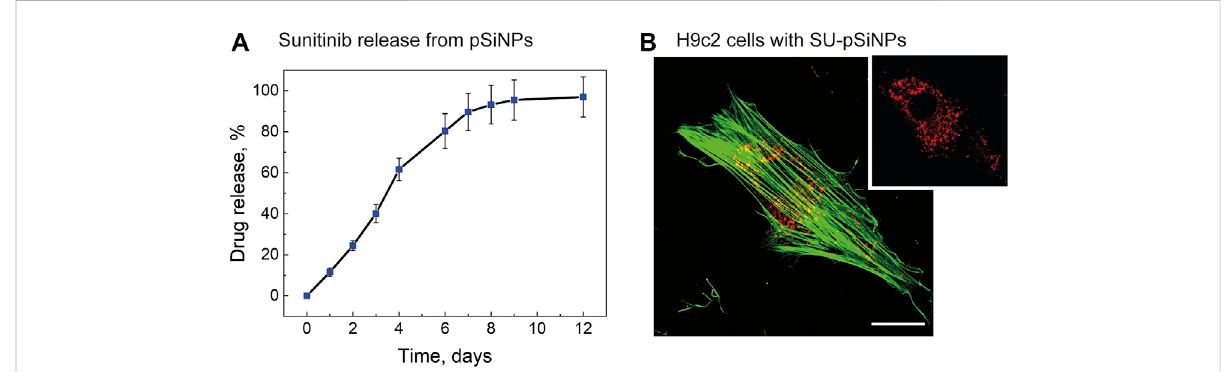
FIGURE 2 (A) Drug release pro fi le of SU loaded into pSiNPs over time (days). Typical release time (50% of payload) is demonstrated after 4 days. (B) A representative fl uorescence image of H9c2 cell treated with SU-loaded nanoparticles for 24 h; the content of SU in the particles was 20 μ M. The cytoskeleton was labeled with Alexa Fluor 488 Phalloidin and is depicted in green. For the visualization of pSiNPs, the laser at 638-nm excitation wavelength was used; the pSiNPs are depicted in red. SU could not be detected with the fl uorescence microscopy without labeling. The scale bar represents 20 μ